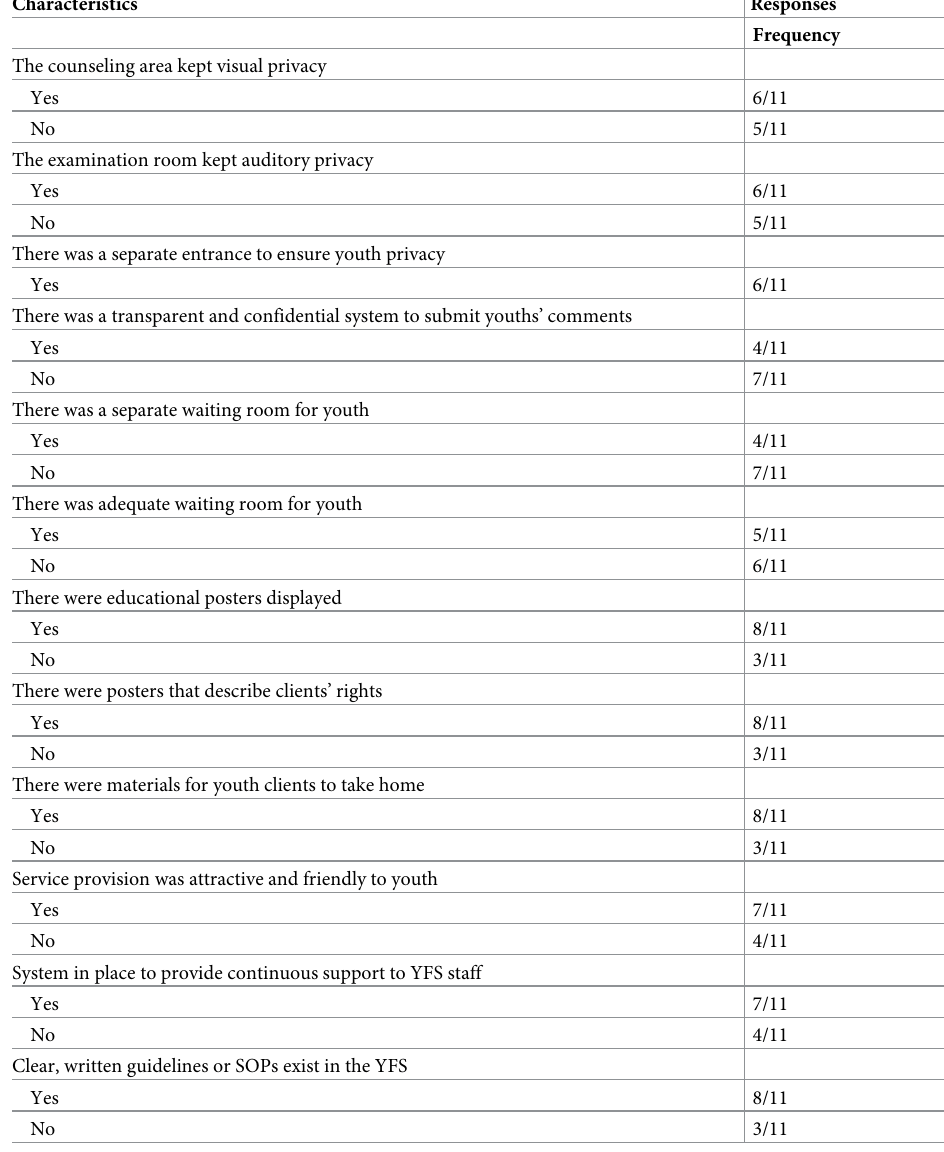
Table 4. The health facility and YFS program level characteristics on YFS, Northwest Ethiopia, 2019.